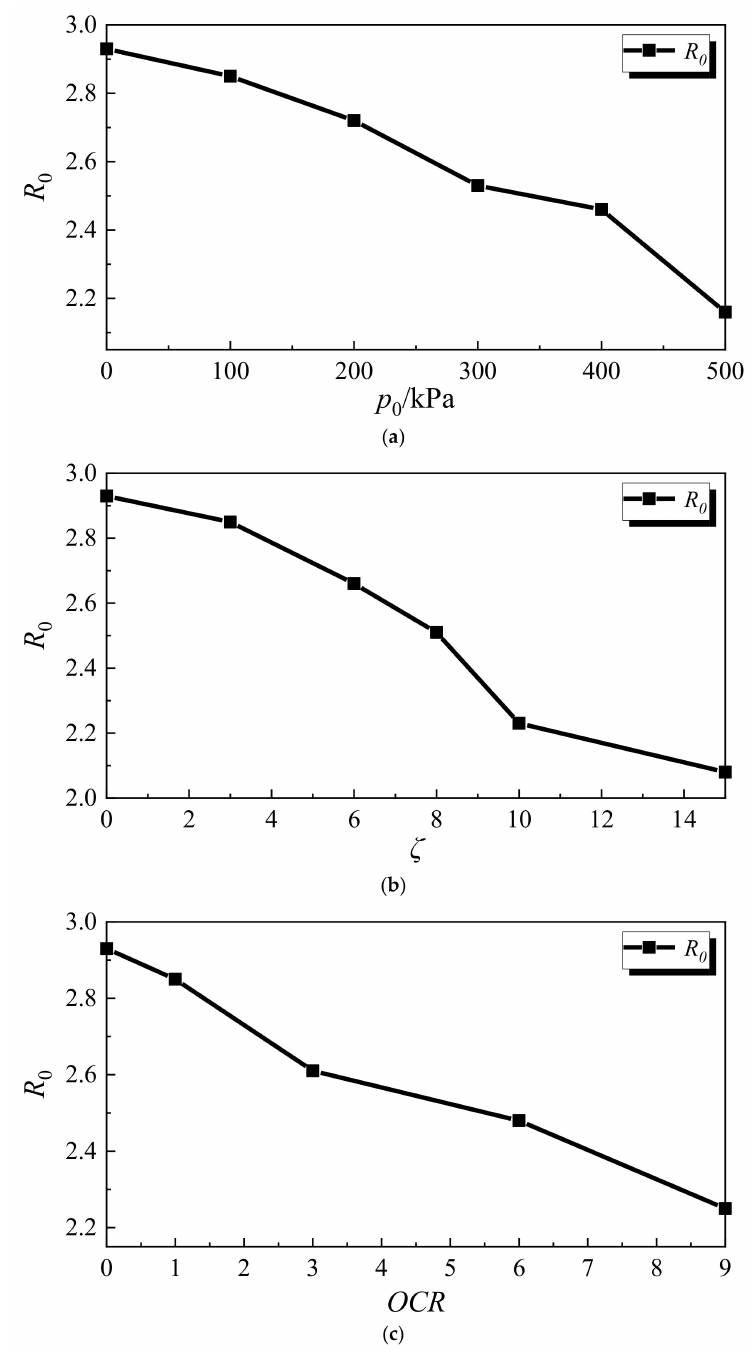
Figure 11. Changes in pore roundness before and after loading under different test